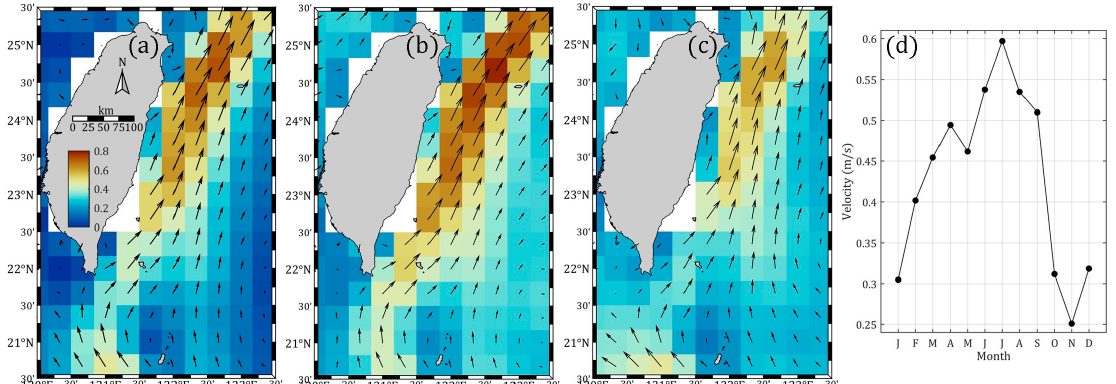
Figure 12. The OSCAR sea surface current velocity from 2010 to 2019, ( a ) the annual mean for ( b ) summer and ( c ) winter and ( d ) the average of the incoming current velocity for each month. Table 2. The statistics for incoming speed (m/s) in front of Green Island for the years of 2010 to 2019. Average